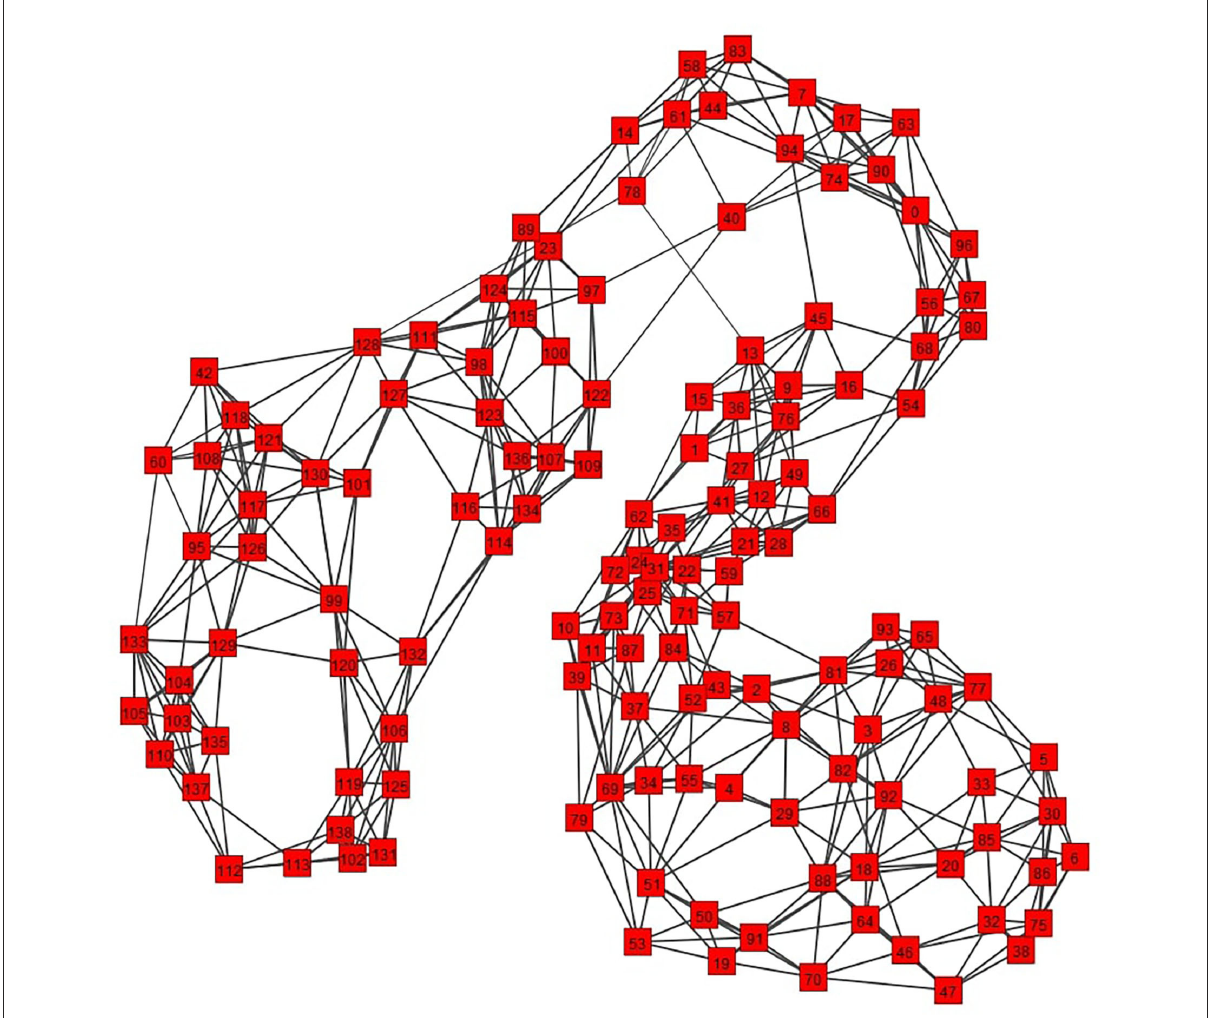
FIGURE10 A force-directed layout [31] of the resulting (sparsified) similarity graph, which uses the Gaussian Kernel as a similarity